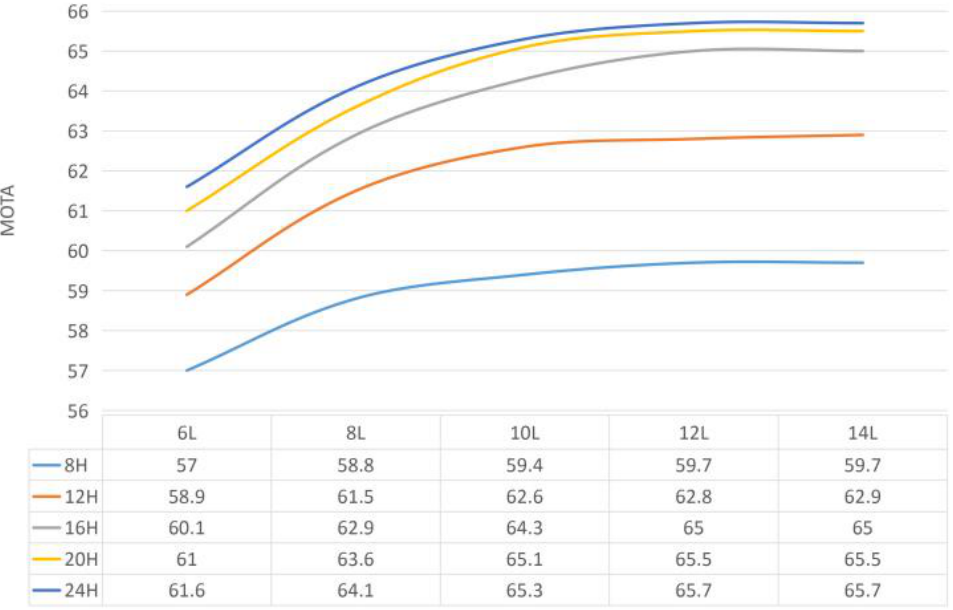
Figure 5. The MOTA metric distribution of ViTT with different layers and heads. The “L” and “H” indicate Layers and Heads, respectively.